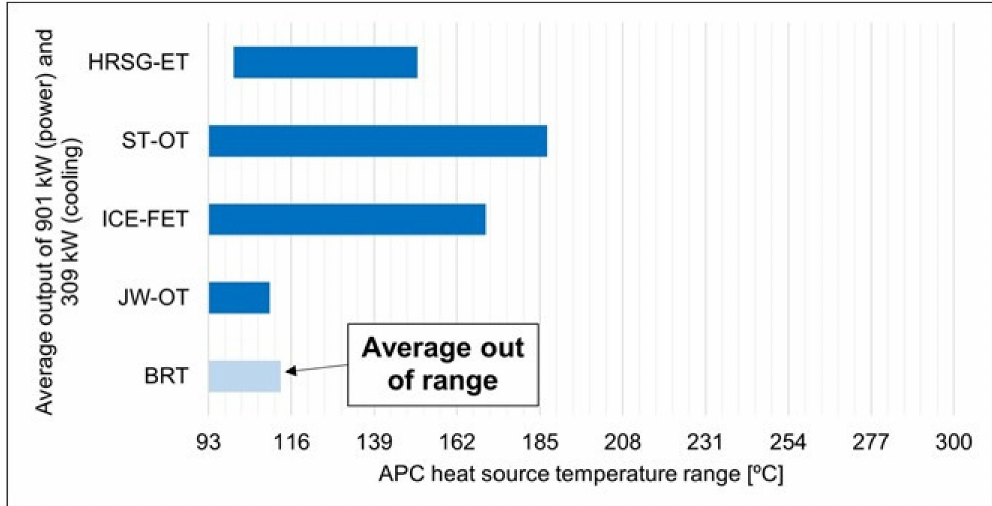
Figure 6. Potential waste heat recovery technologies suitable for feeding Absorption Power and Cooling